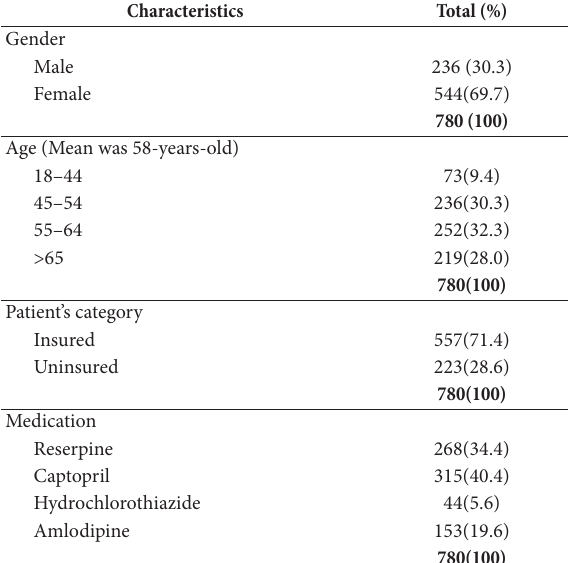
Table 1. Patient characteristics.